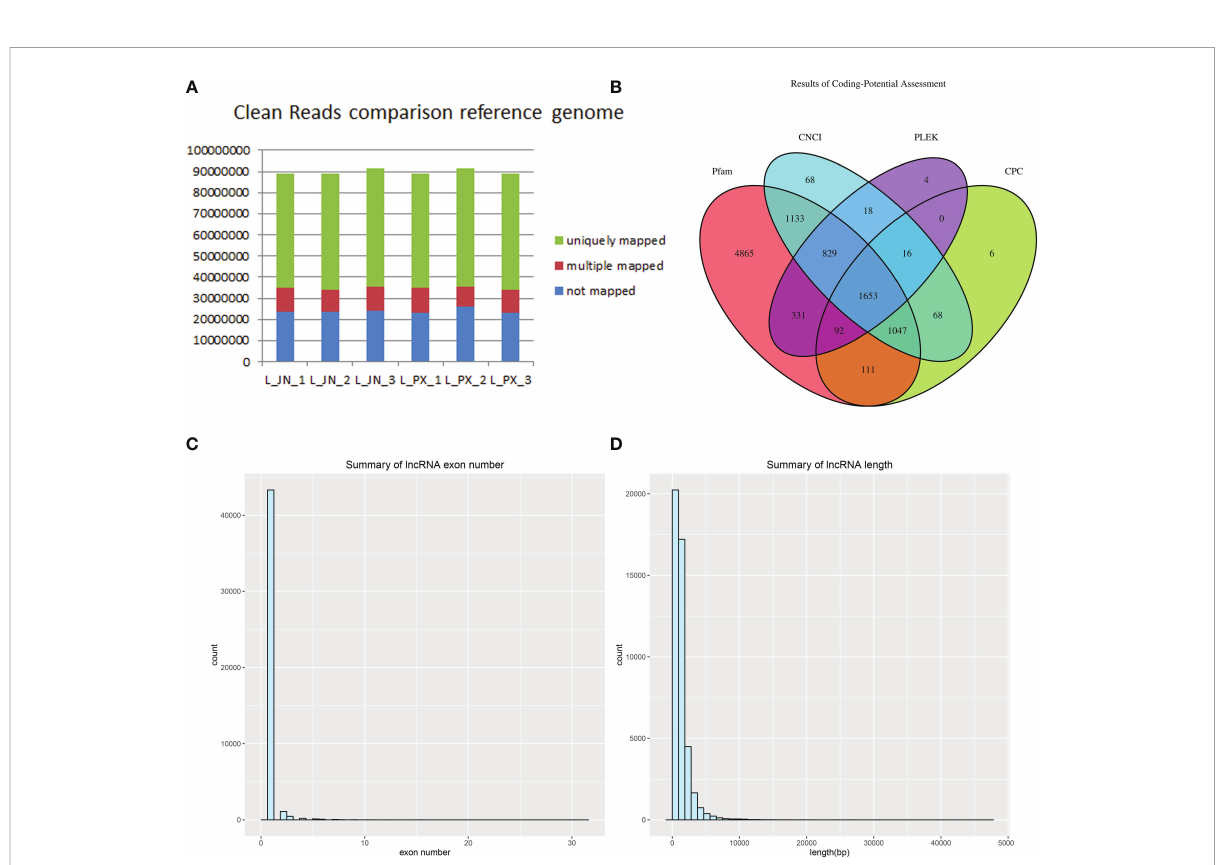
FIGURE 1 Long RNA comparison reference genome results (A) lncRNA database comparison results (B) The count of lncRNA exons (C) Transcript length distribution (D) .